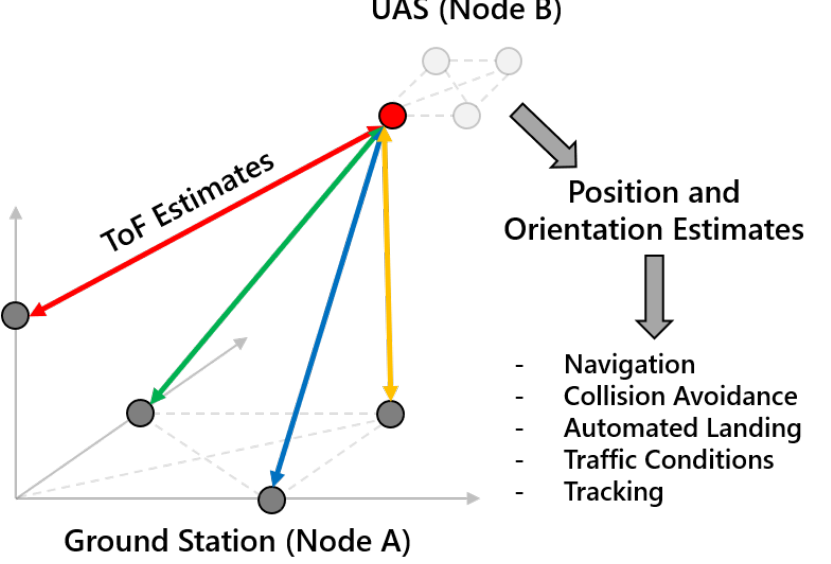
Figure 1. CHP2 is flexible and reconfigurable, which enables diverse network configurations on a variety of platforms. CHP2 supports both ground and aerial users, and can be tuned for both close-range and long-range applications. G2G links enable applications such as traffic management, knowledge distribution, and automatic navigation. A2G links enable applications such as ATM; flexible traffic surveillance; PNT; automated landing; and CNS. A2A links enable airborne applica- tions such as collision avoidance, formation control, PNT, and CNS without relying on satellite links (which are susceptible to spoofing cyberattacks) or ground links—which are not always